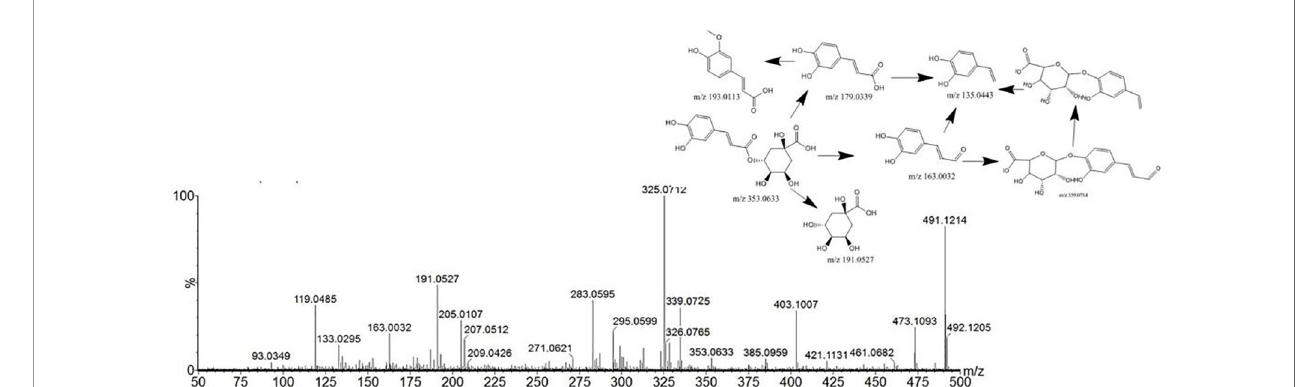
FIGURE 4 | Tandem mass spectra and possible fragment pathways of chlorogenic acid in positive ion mode.